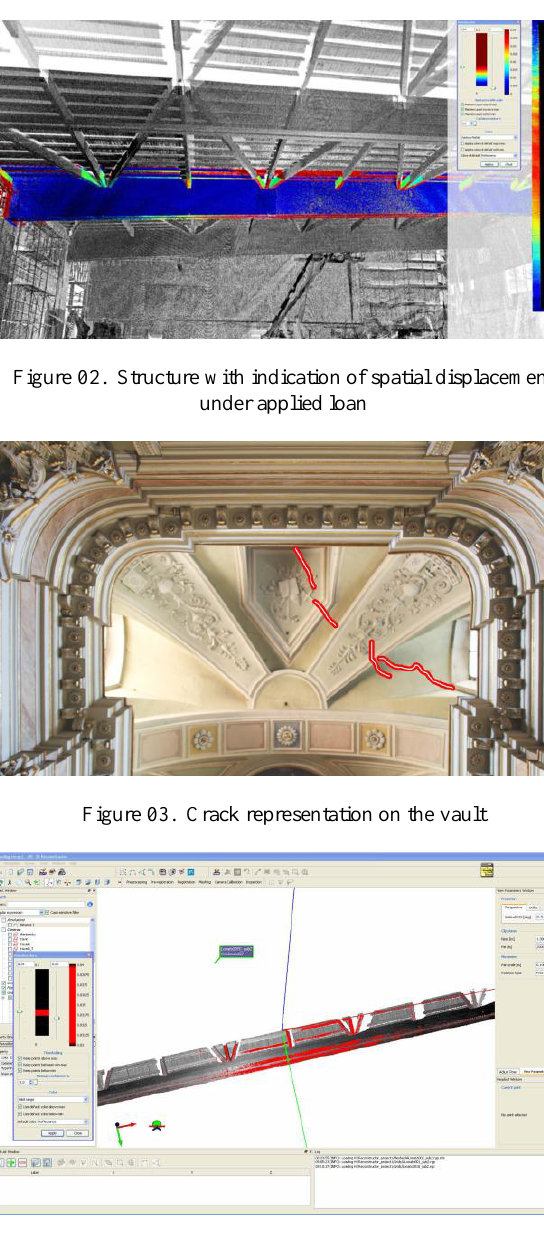
Figure 04. GEXCEL JRC-3D Reconstructor’s visualization of the structural beam deflection